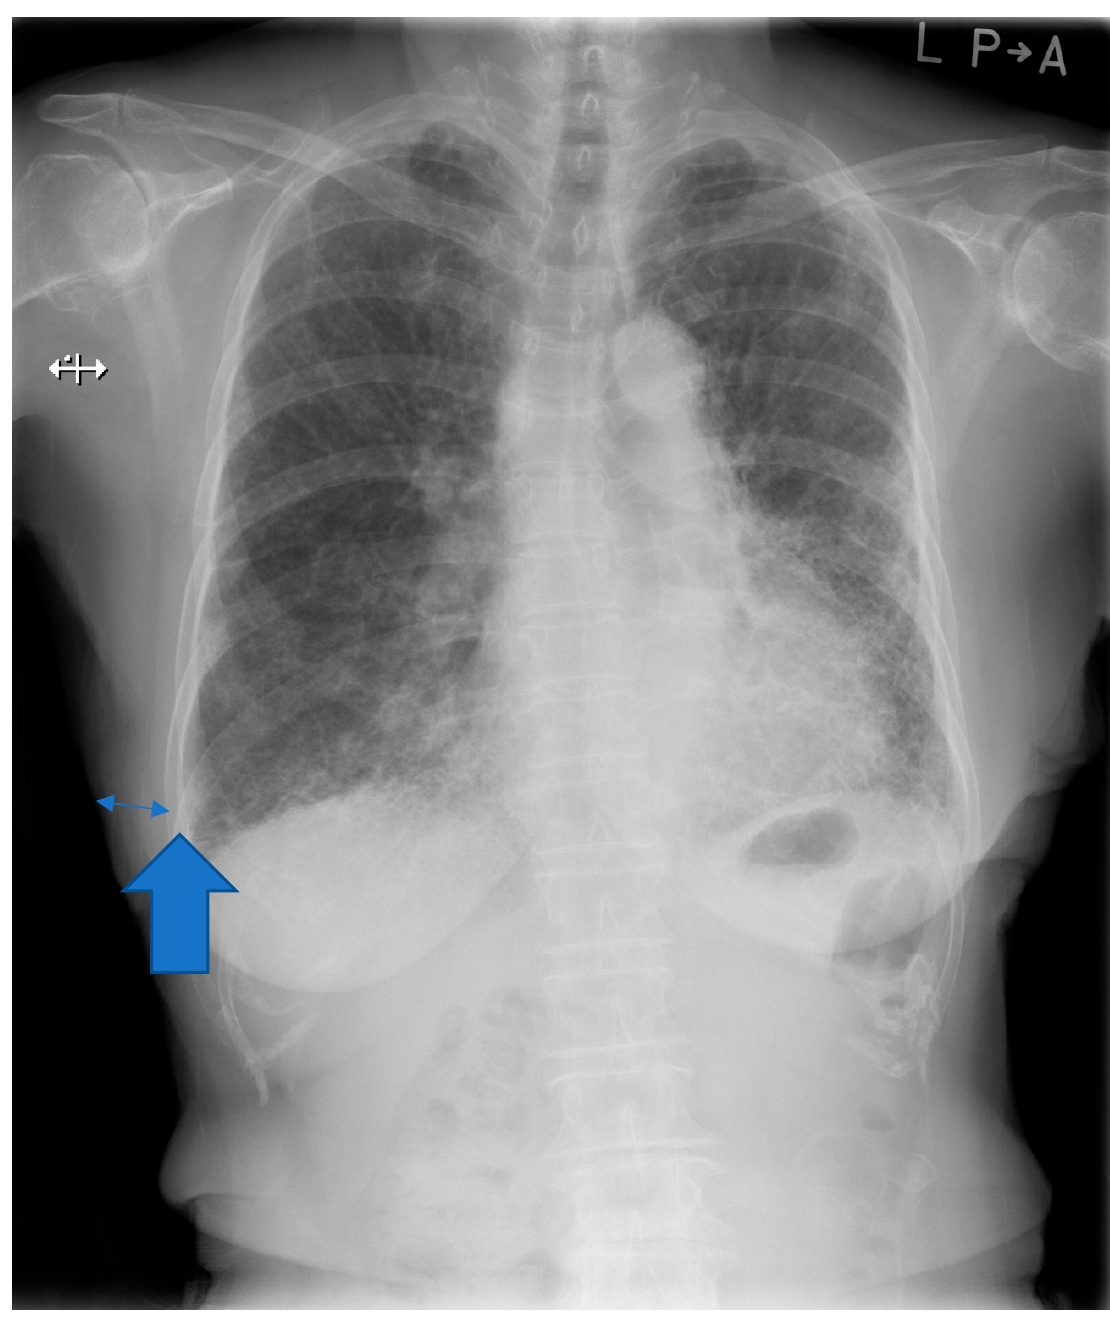
Figure 1. Evaluation of soft tissue thickness in the chest radiograph. Thin double arrow indicates soft tissue thickness. Thick arrow indicates outer edge of the right 9th rib.